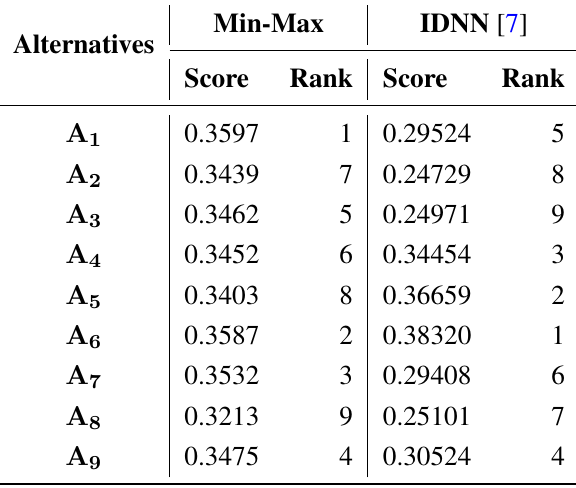
Table 9. Ranking in the machine selection